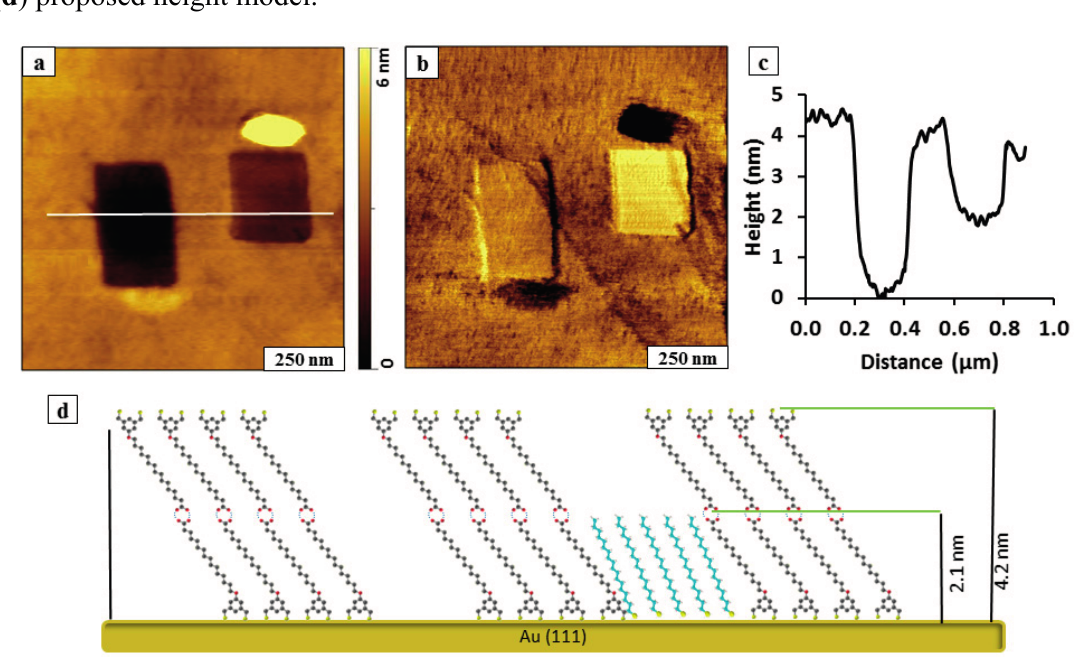
Figure 5. A nanoshaved area and nanografted pattern of ODT placed side-by-side within a BMPHA bilayer. ( a ) Topography image; ( b ) lateral force frame; ( c ) cursor profile for a ; ( d ) proposed height